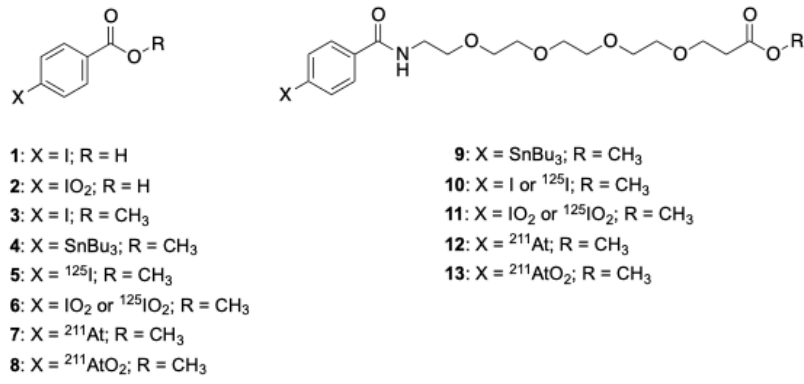
Figure 1. Structures of p -(radio)halobenzoic acid derivatives synthesized.